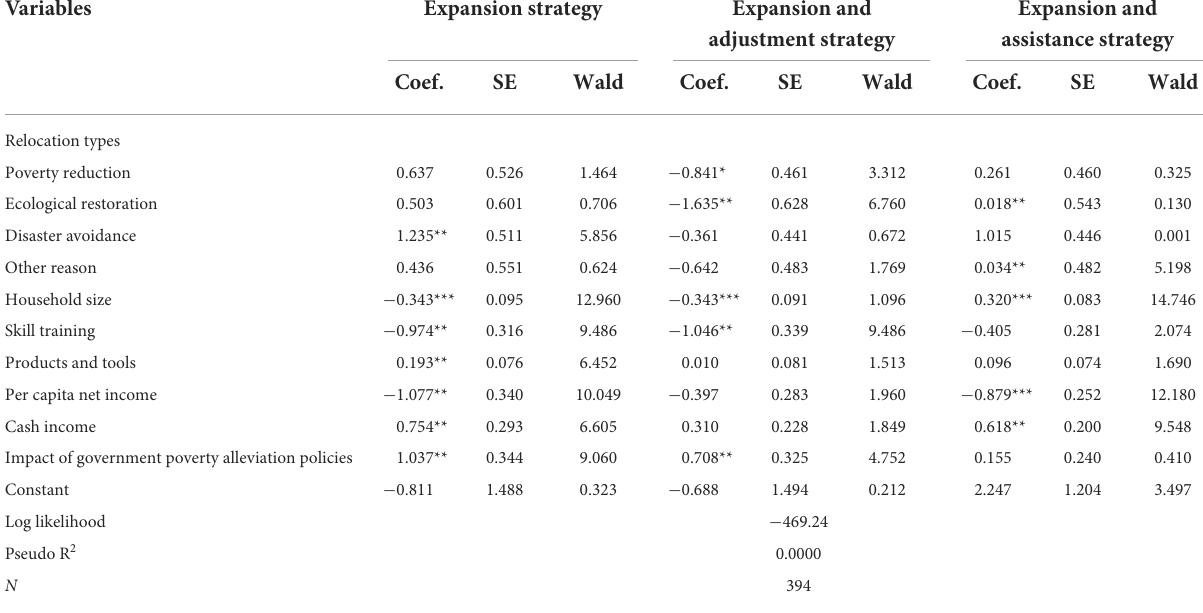
TABLE 3 The impact of relocation types on the choice of adaptation strategy.